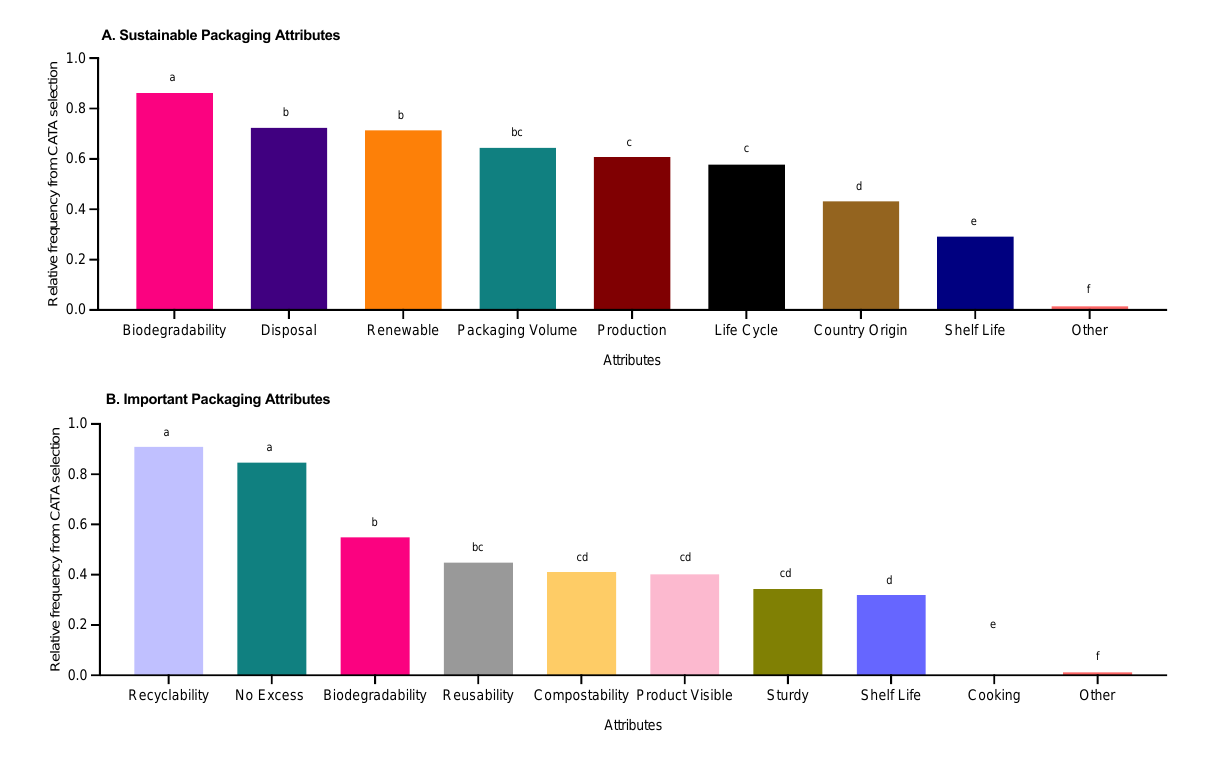
Figure 6. Summary of consumers’ ( n = 405) key sustainable packaging attributes. Data was derived from CATA selection and expressed as relative frequency with differing letters reflect significance from post hoc analysis ( p < 0.05).